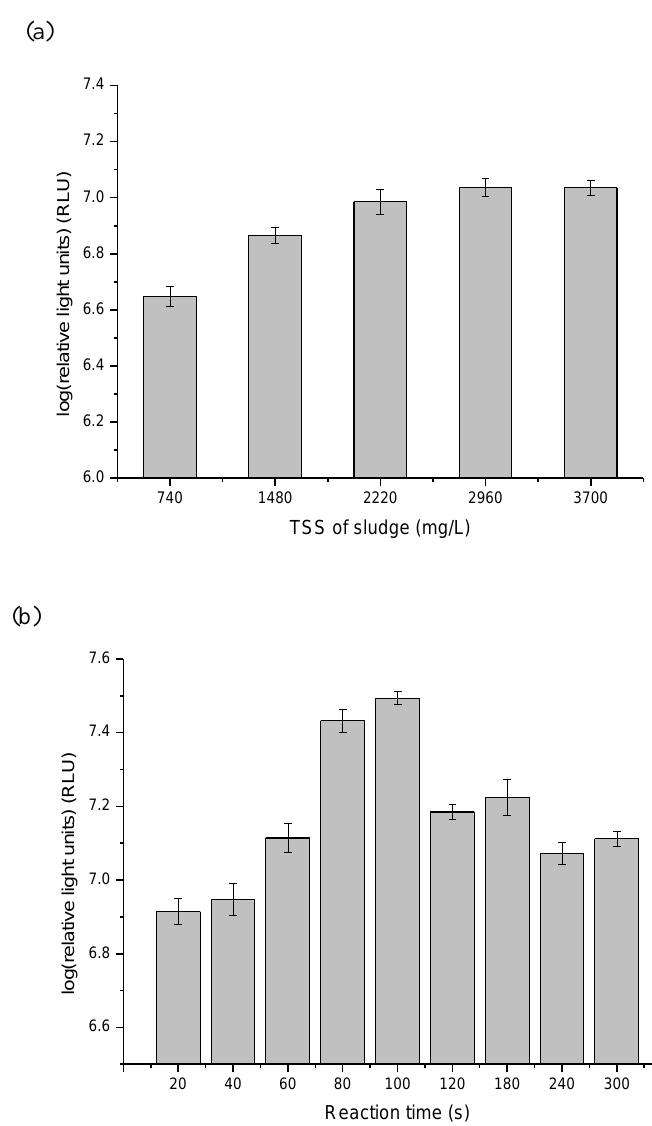
Figure 1. Optimization of the ATP detection for the sludge samples: ( a ) effect of sludge solid contents on the luminescence; and ( b ) effect of reaction time on the luminescence.